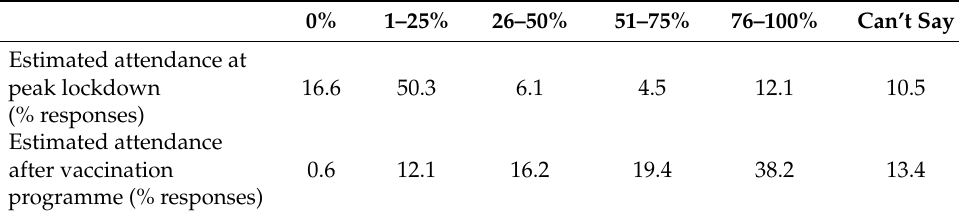
Table 5. Estimated number of employees working during the pandemic (n = 280).